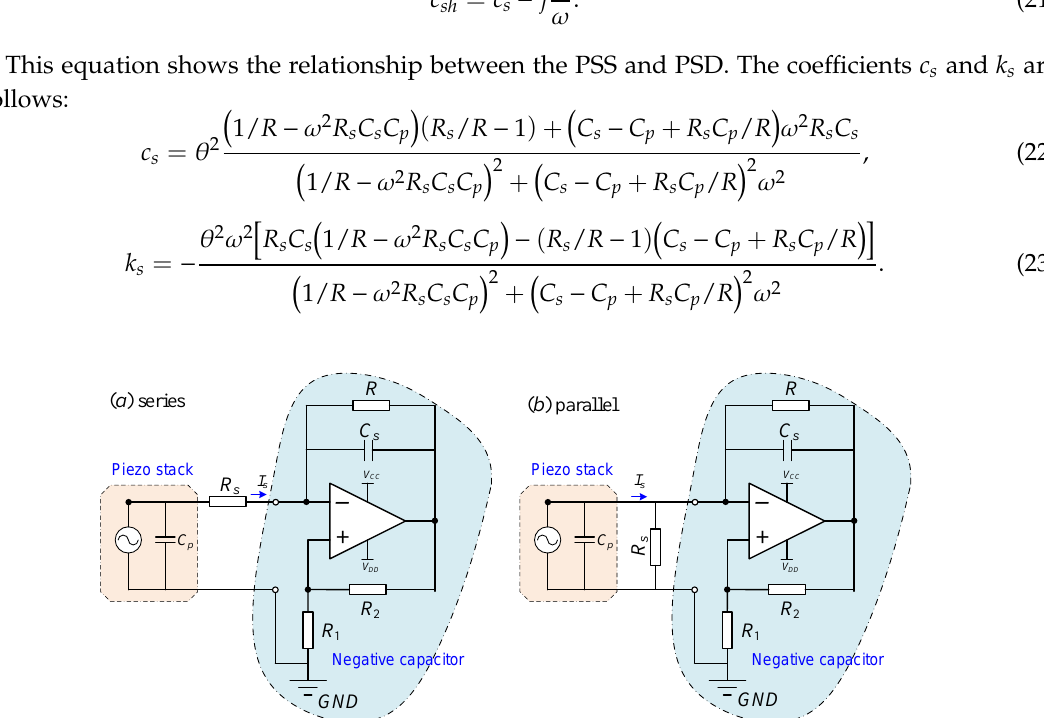
Figure 3. Complex plot of capacitance considering both the positive and negative cases.